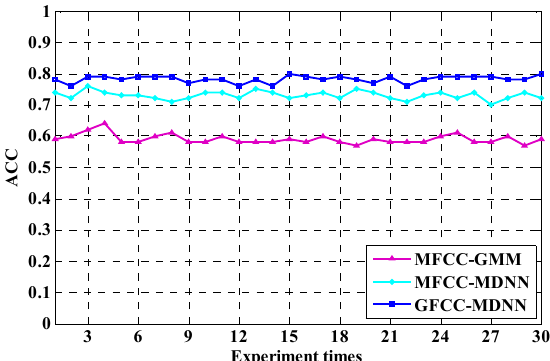
Figure 12. The recognition accuracy of the Mel frequency cepstral coefficient-Gaussian mixture model (MFCC-GMM), the Mel frequency cepstral coefficient-modified deep neural network (MFCC-MDNN) and the Gammatone frequency cepstral coefficient-modified deep neural network (GFCC-MDNN).